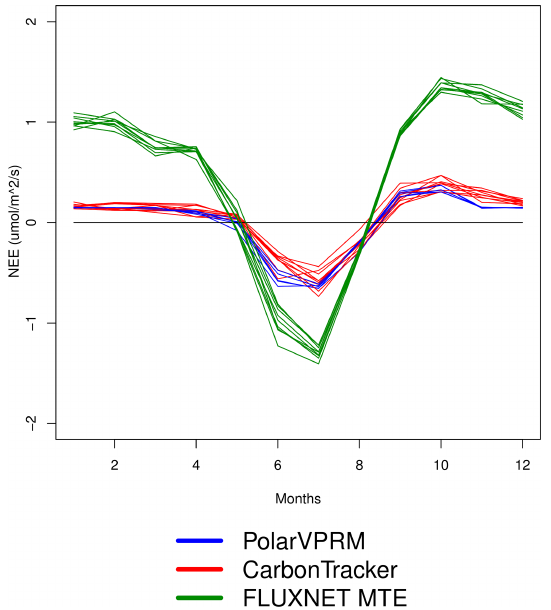
Figure 3. Monthly average NEE for high-latitude North America (north of 55 ◦ N from PolarVPRM (blue), FLUXNET MTE (green) and CarbonTracker (red). Average values are indicated for each year (2001–2009)